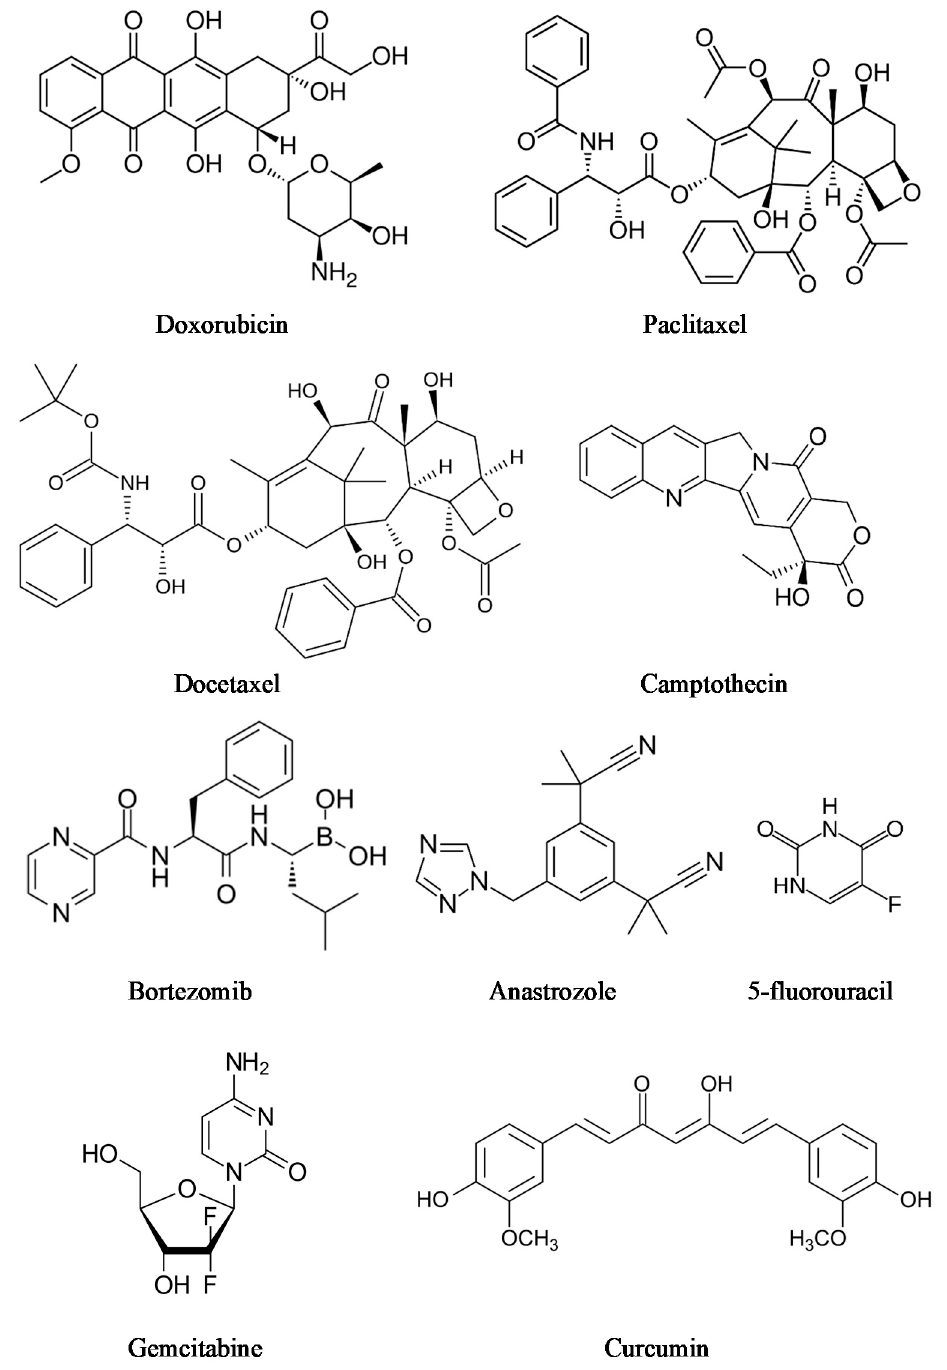
Figure 7. Anti-cancer